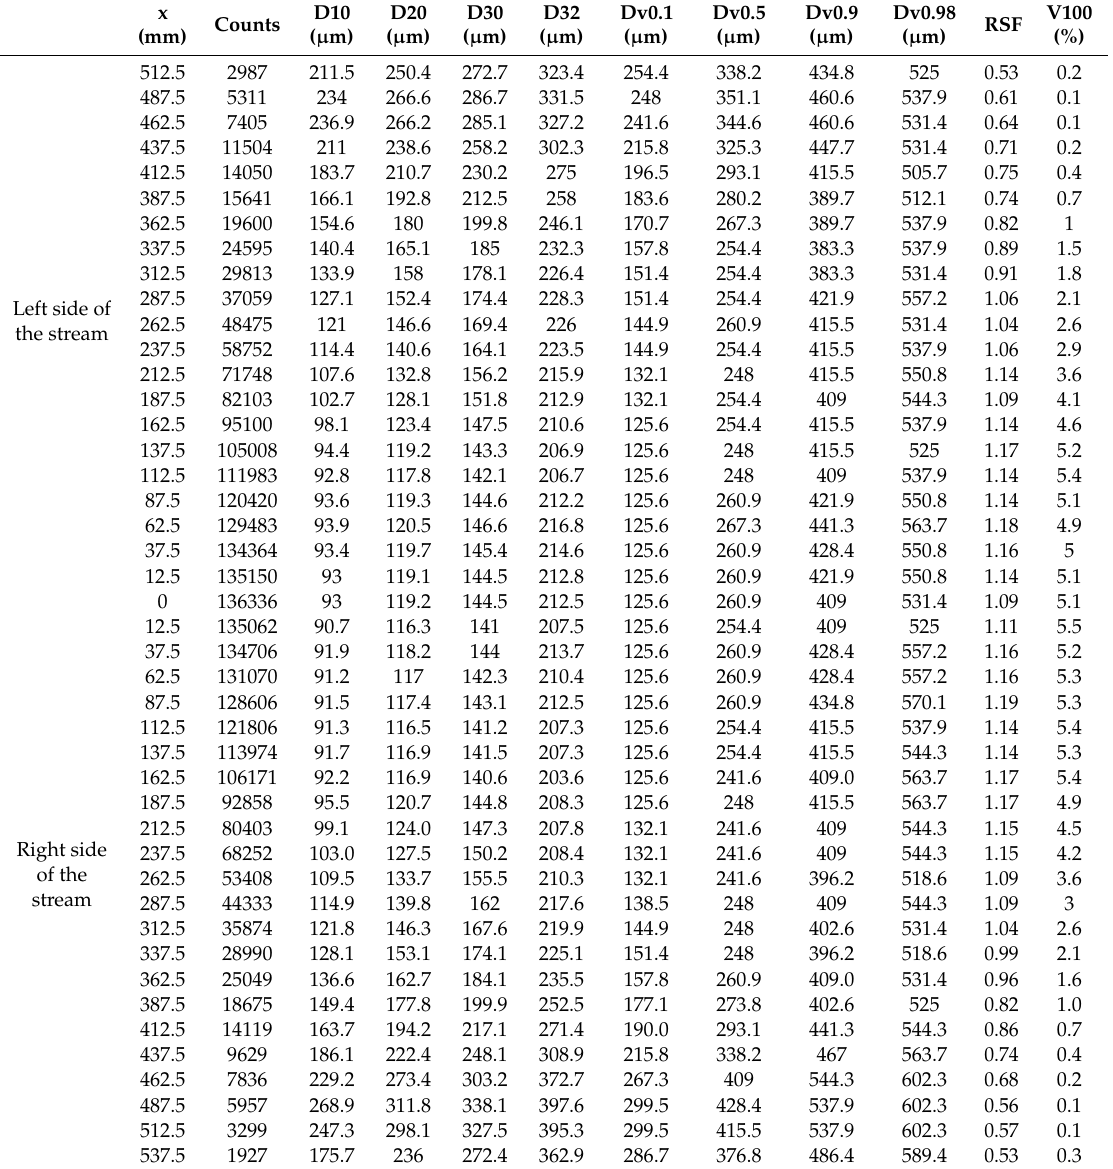
Table 3. The results of the drop spectrum tests in the subsequent points of the PDA analysis for nozzle number